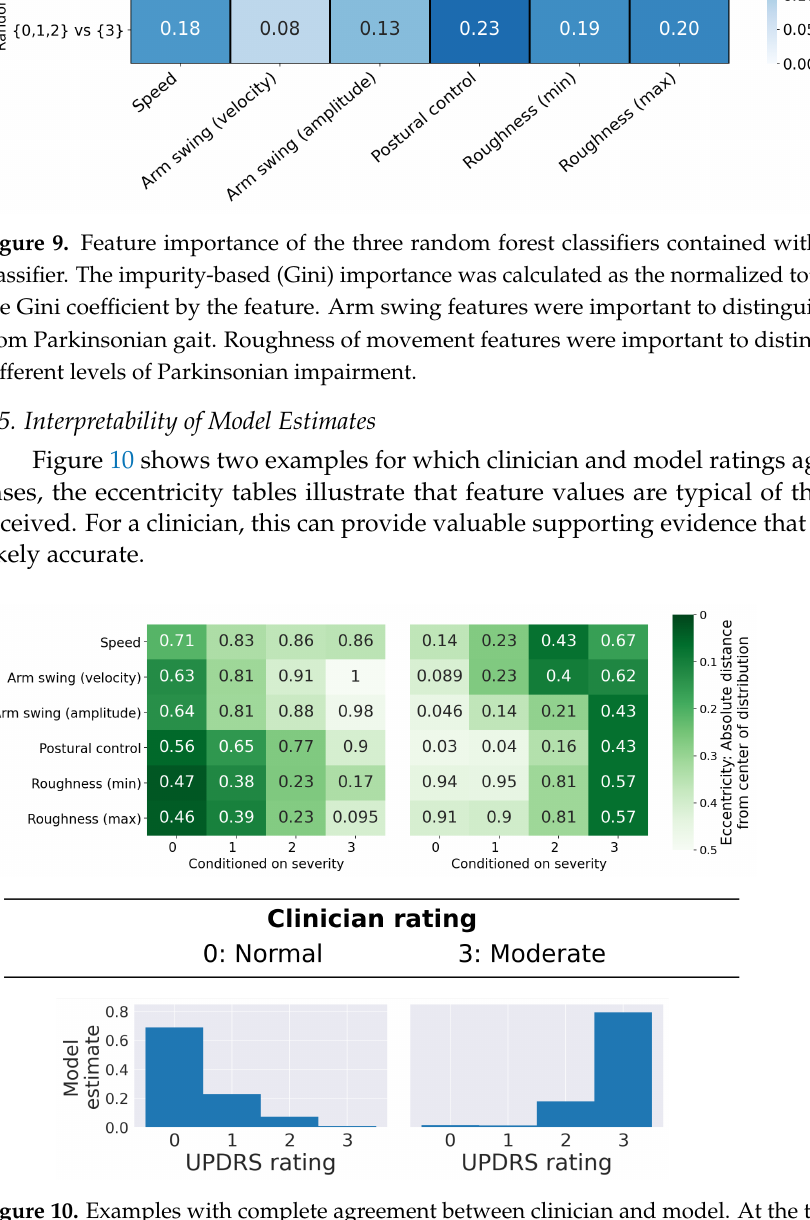
Figure 10. Examples with complete agreement between clinician and model. At the top, eccentricity tables for patients who were rated as “normal” ( left ) and “moderately impaired” ( right ) are shown. At the bottom, the model’s estimates for the two examples are shown. In both cases, the model agreed with the clinician and estimated the correct ratings with high